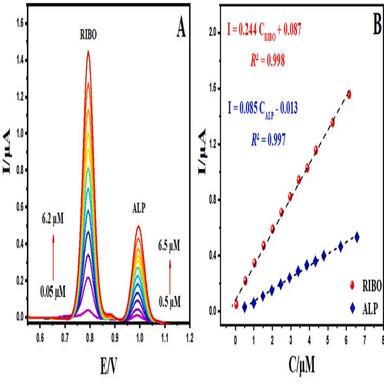
(A) DPVs of simultaneous detection of RIBO and ALPE in concentration ranges (0.05 → 6.2 μM) and (0.5 → 6.5 μM) in 0.1 M PBS pH 1.0; and (B) the corresponding calibration curves for RIBO and ALPE.